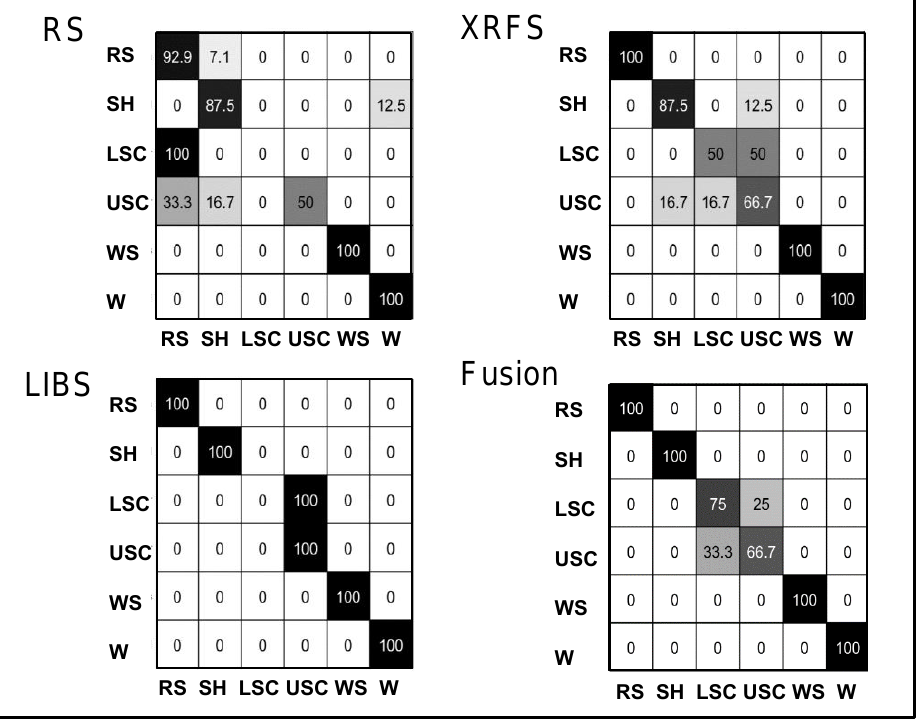
Figure 8. Classification matrices for each individual analyzer for the New Mexico soil suite (RS, top left; XRFS, top right; LIBS, bottom left) and the data fusion (bottom right). Each row indicates the samples’ true class label and each column indicates the classifier label given to the samples analyzed from this class. Each entry is the percent (%) of samples with a row’s true label that were assigned a column’s label by the classifier. The diagonal entries indicate correctly classified samples and the off-diagonal entries indicate misclassifications. Location abbreviations are as follows: RS = Rio Salada, SH = Sedillo Hill, LSC = Lower Socorro Canyon, USC = Upper Socorro Canyon, WS = White Sands, and W = Willard.